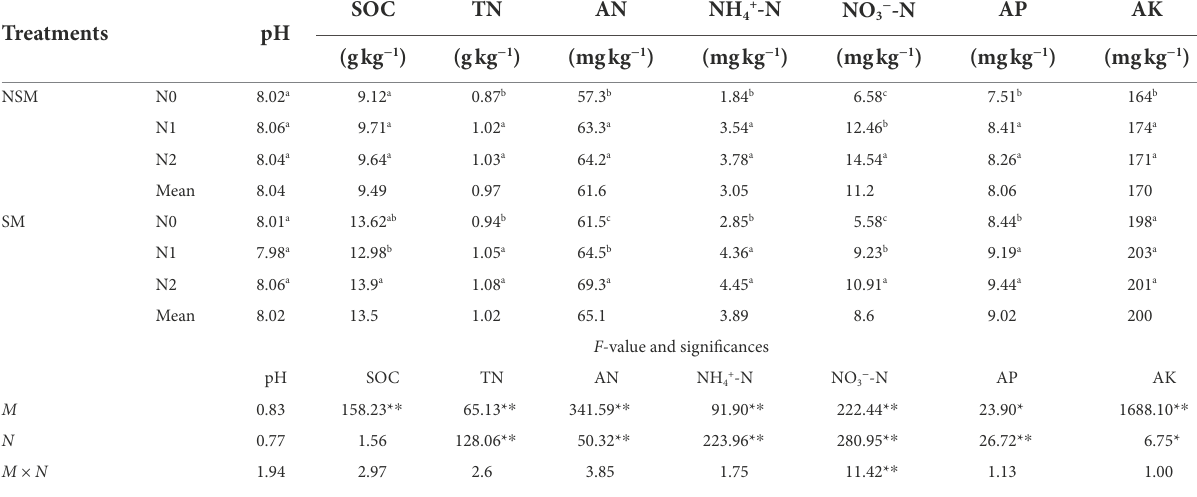
TABLE 1 Physicochemical properties of wheat rhizosphere soil in the straw mulching and N fertilization treatments.